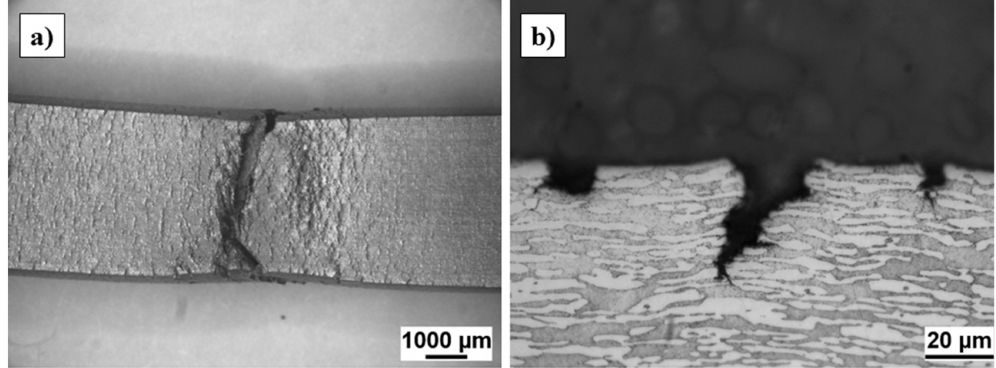
Figure 11. Macrograph ( a ) and micrograph ( b ) of the long transversal section of DSS 2304 sample after SSRT in NACE TM-0177 solution at 25 ◦ C and pH 2.7, in the presence of 10 − 2 M S 2 O 32 − .